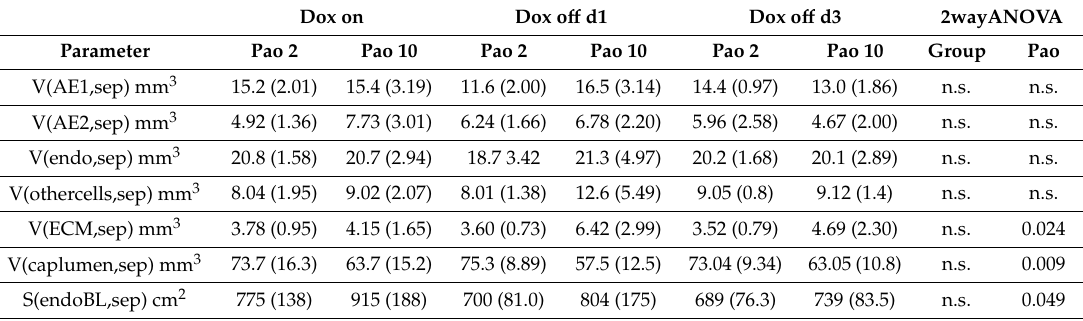
Table 2. Composition of interalveolar septa.